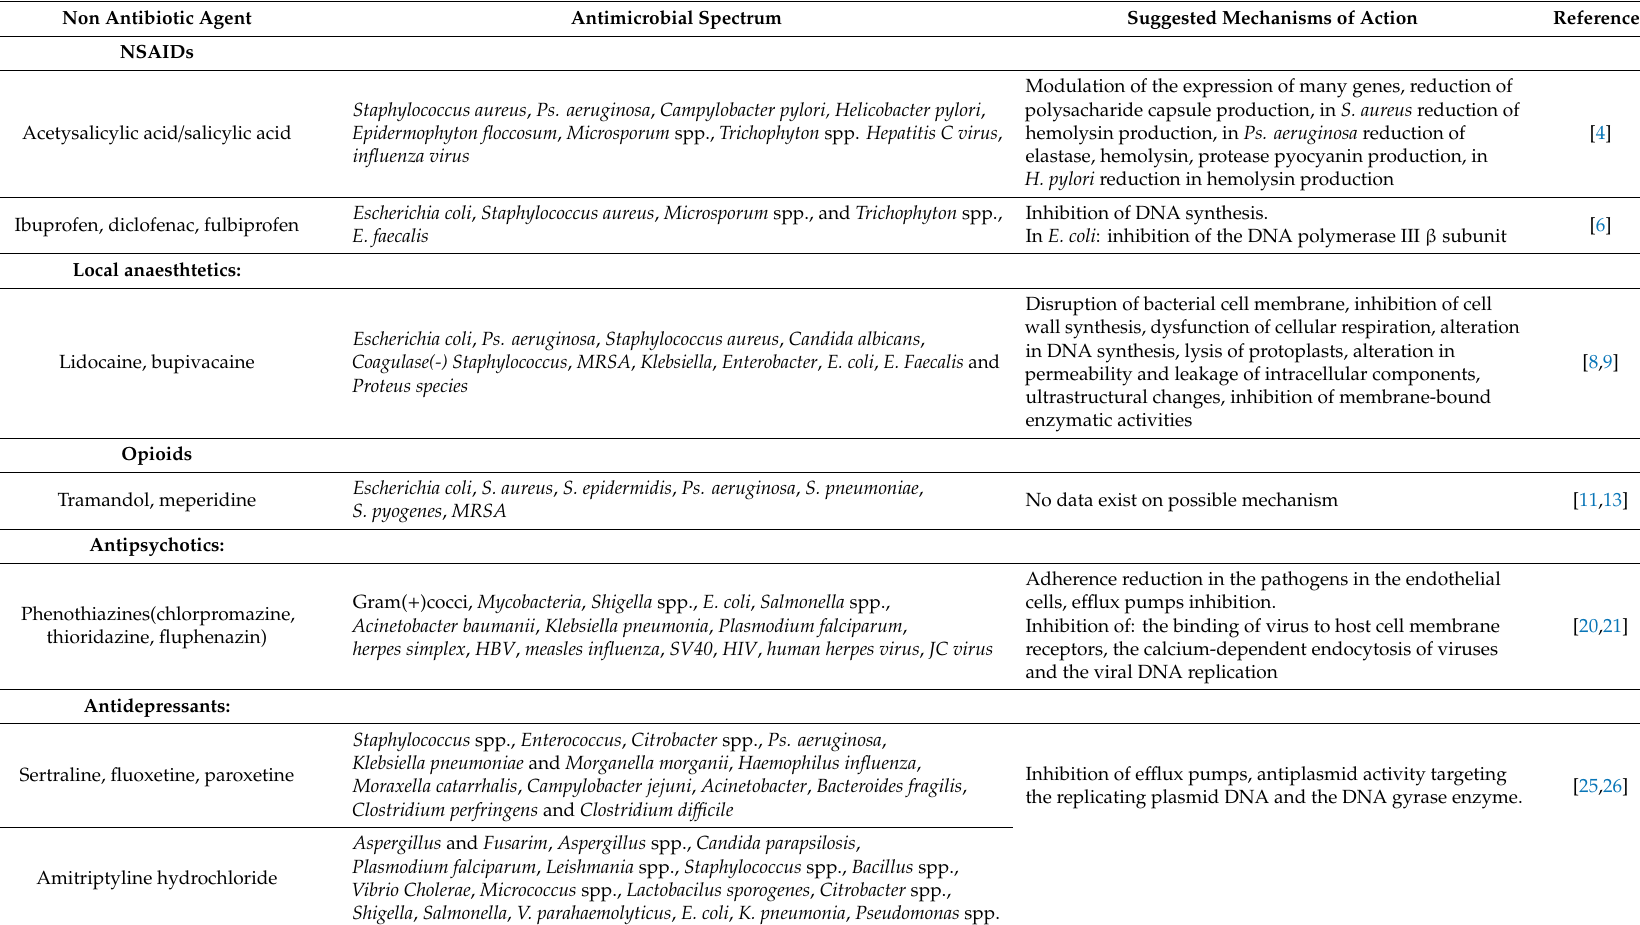
Table 1. Non-antibiotic agents with antimicrobial activity, their antimicrobial spectrum and approved or potential mechanisms of